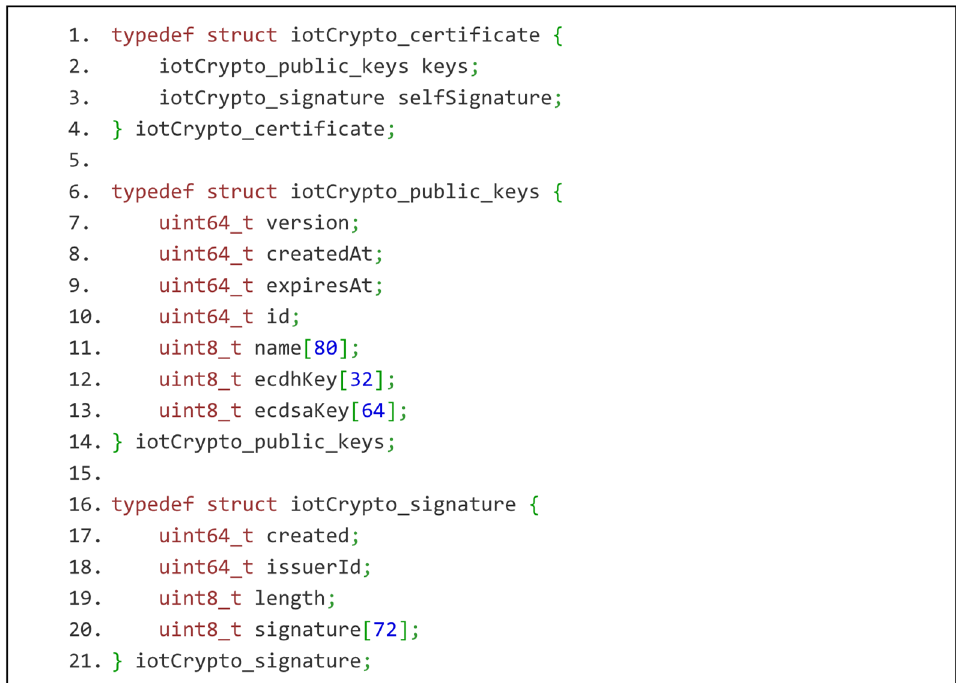
Figure 2. IoT-Crypto certificate as C structures. The certificate consists of public keys with their metadata and self-signature. Third-party signatures have the same structure as self-signature. They are, however, independent entities stored and transmitted separately from the certificate.